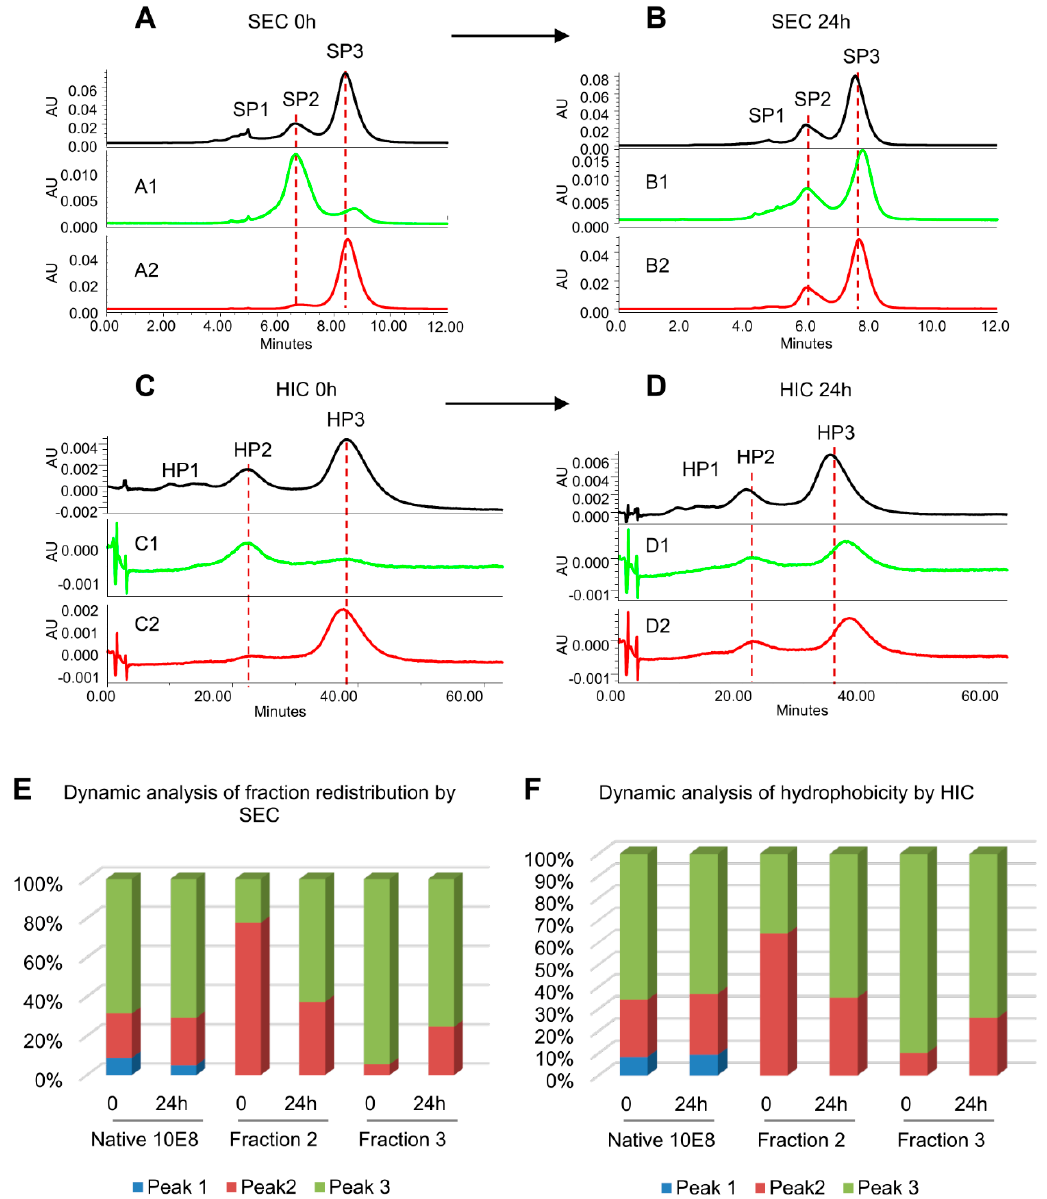
Figure 3. Conversion of isolated and reinjected 10E8VLS fractions from SEC (A’s and B’s) and HIC (C’s and D’s) at time 0 and after 24 h. ( A ) SEC profiles of 10E8VLS neat injection at T0. A1 and A2: collected fraction 2 and 3 by SEC and reinjected to SEC column at T0. ( B ) SEC profiles of 10E8 native after 24 h incubation at 25 °C. B1 and B2: collected fraction 2 and 3 by SEC and reinjected to SEC analysis after 24 h incubation at 25 °C. ( C ) HIC profiles of 10E8 native at T0. C1 and C2: collected fraction 2 and 3 by SEC and reinjected to HIC column at T0. ( D ) HIC profiles of 10E8 native after 24 h incubation at 25 °C. D1 and D2: collected fraction 2 and 3 by SEC and reinjected to HIC analysis after 24 h incubation at 25 °C. ( E ) Bar graph of conversion trend after fractions being reinjected to SEC column. ( F ) Bar graph of the conversion trend after fractions being reinjected to HIC column.